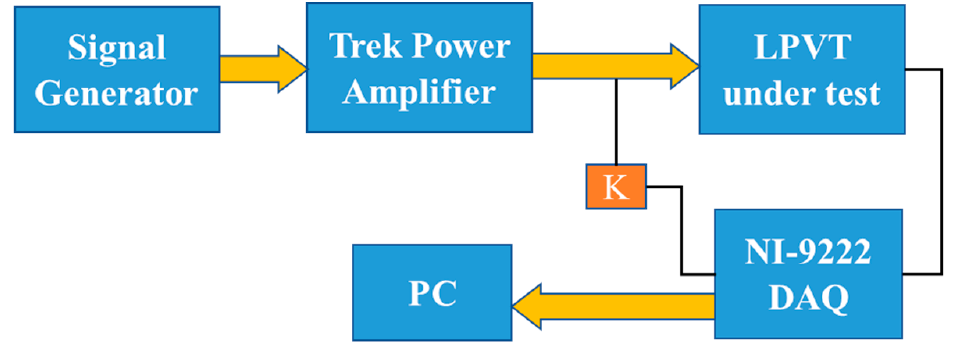
Figure 4. Experimental test setup scheme.